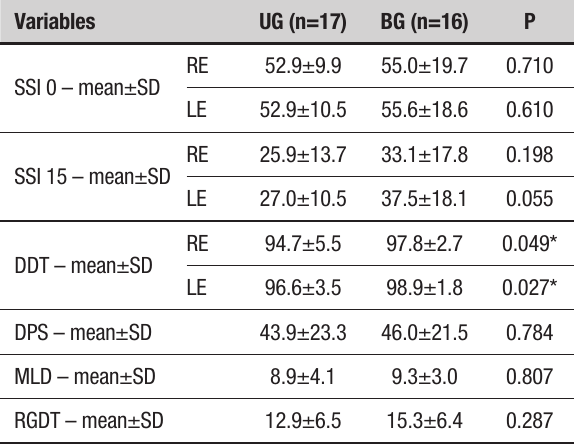
Table 4. Central auditory processing tests in SG subjects with unilateral and bilateral conductive